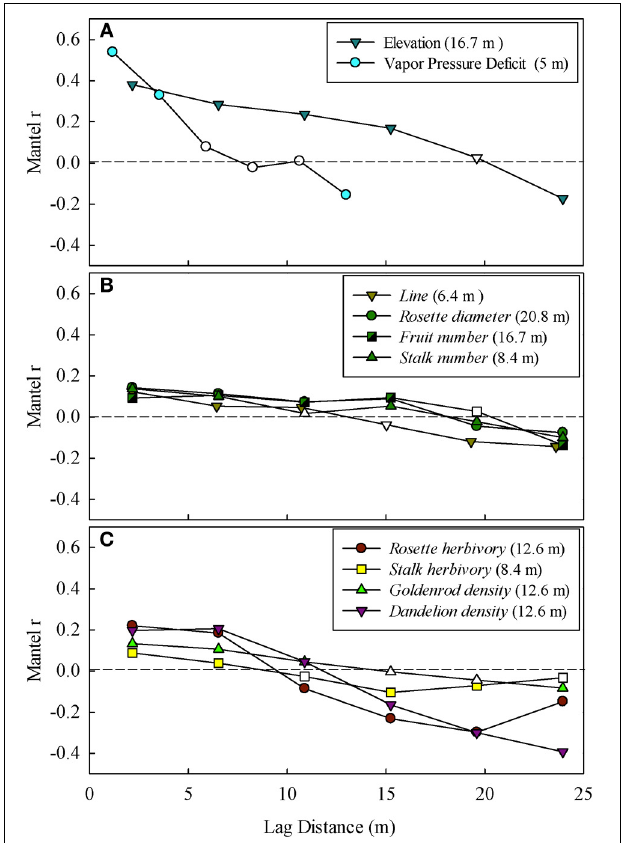
FIGURE 2 | Mantel correlograms showing significant spatial autocorrelation for (A) abiotic environmental factors (Elevation, and Vapor pressure deficit), (B) intra-specific performance and fitness measures ( rosette diameter , stalk number , stalk diameter , fruit number , and line), and (C) inter-specific neighbors and herbivory ( goldenrod density , dandelion density , rosette herbivory , and stalk herbivory ). Filled (significant) and open (non-significant) circles represent statistical significance ( P ≤ 0.05) of Mantel correlation coefficients and each point marks the middle point of the respective lag distance bin. The range of autocorrelation for each variable is given next to the legend. Only significant ( P ≤ 0.05) correlograms are